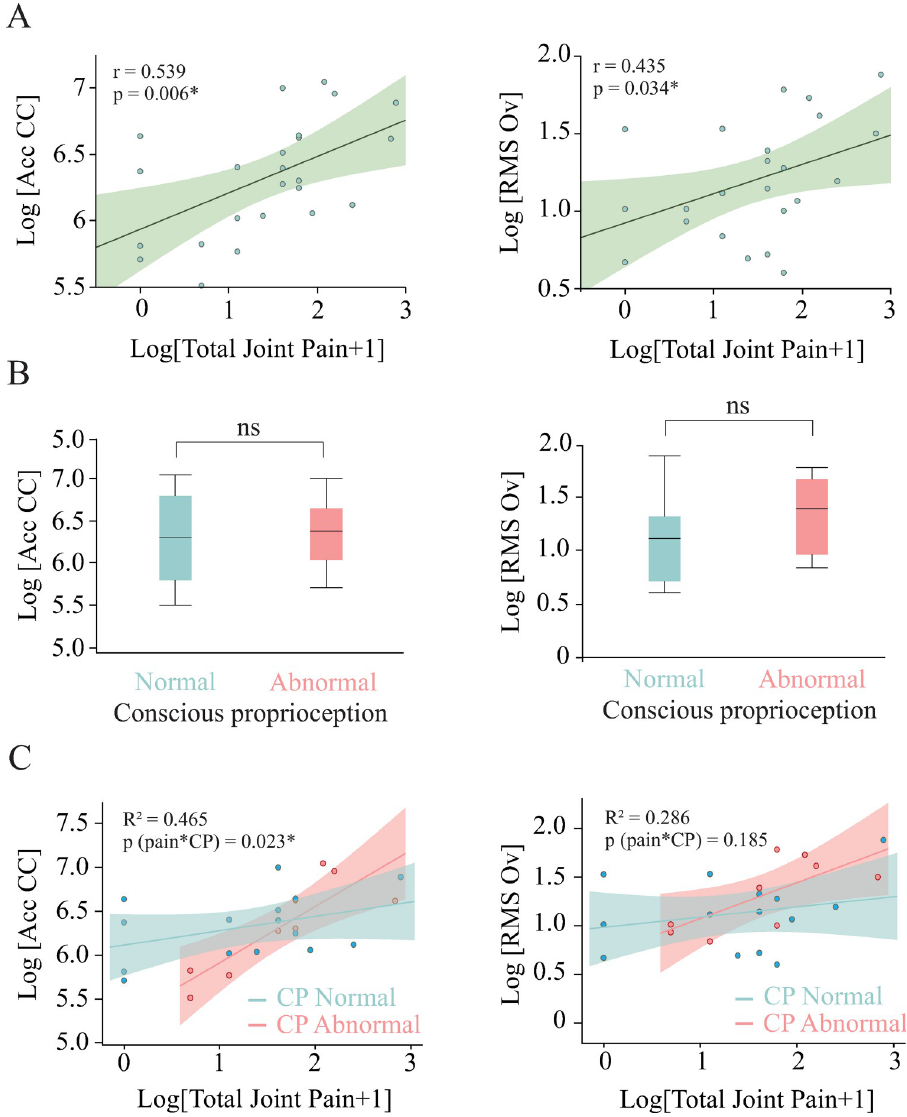
Fig 4. Relationship between postural stability and, total joint pain and conscious proprioception. A. Correlation between total joint pain and Acc CC (left) and RMS Ov (right) in older dogs. B. Differences in Acc CC (left) and RMS Ov (right) between older dogs with normal and abnormal proprioception. C. Relationship between total joint pain and Acc CC (left) and RMS Ov (right) for dogs with normal and abnormal proprioception. The effect of the interaction total joint pain � CP was evaluated and p values are shown in the